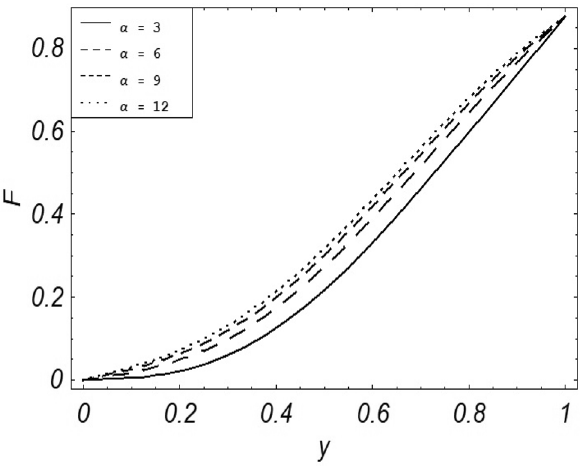
Figure 7. Evolution of F with various values of α if t = 1 ; Gr = 2.5 ; N = 0.7 ; K = 0.5 ; η = 2 � = 0.5 ; Re = 1 ; M = 0.1 ; ω = 0.5 ; ε = 0.001 .